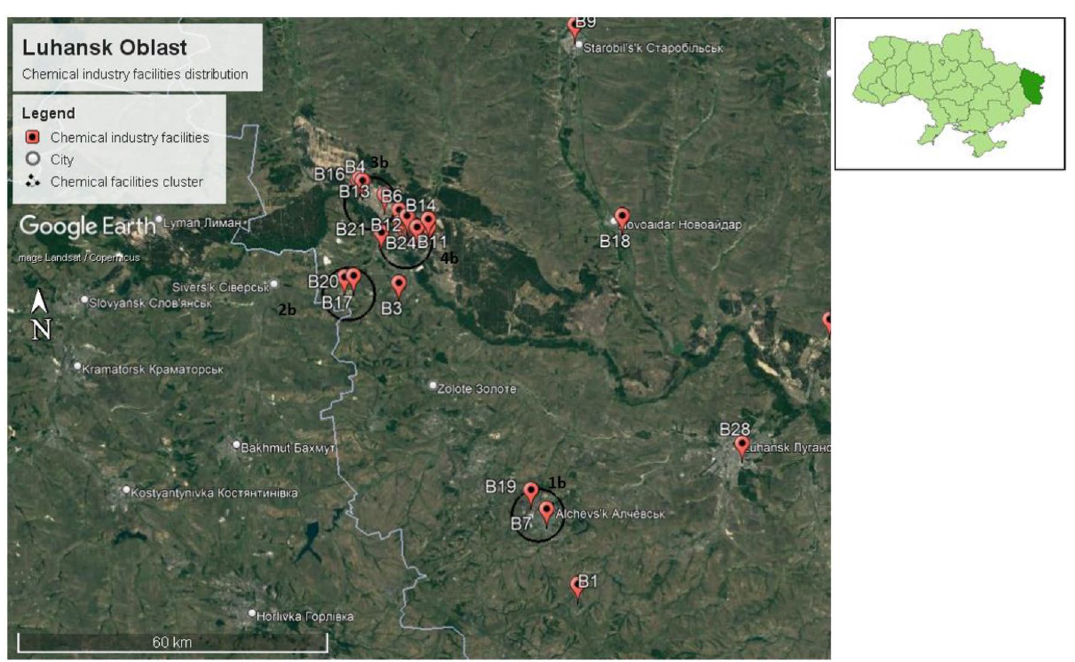
Figure 14. Chemical facilities cluster identified in Luhansk